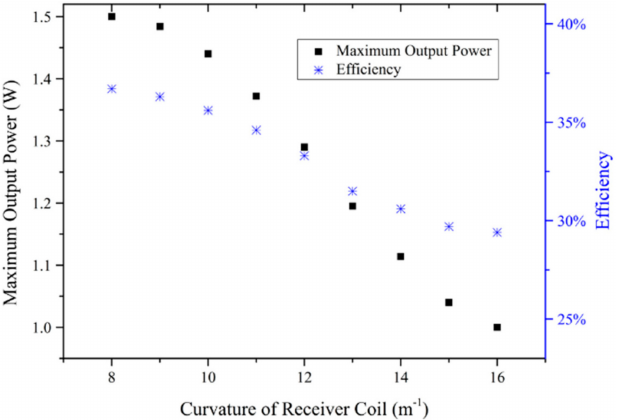
Figure 12. Maximum output power and DC to DC efficiency of WPT employed flexible coils with varying curvature of receiver coil at 5 mm center separation distance from transmitter coil. The maximum output power drops 33% as a result of the deformation of the receiver